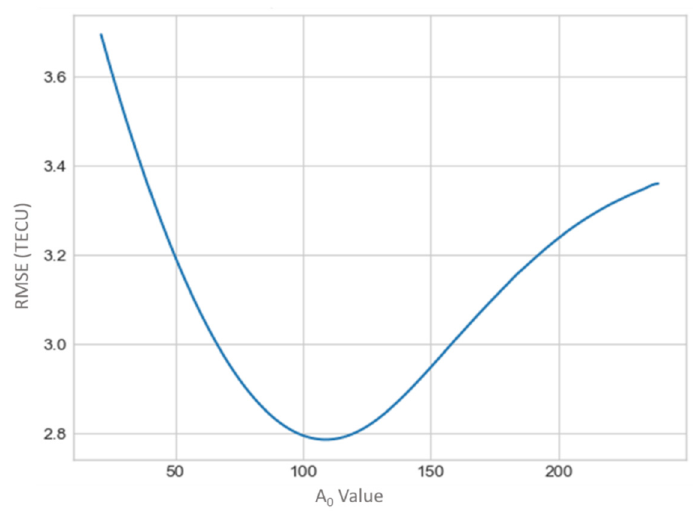
Figure 6. Minimization of RMSE (at A 0 = 118) to be used for the next day.